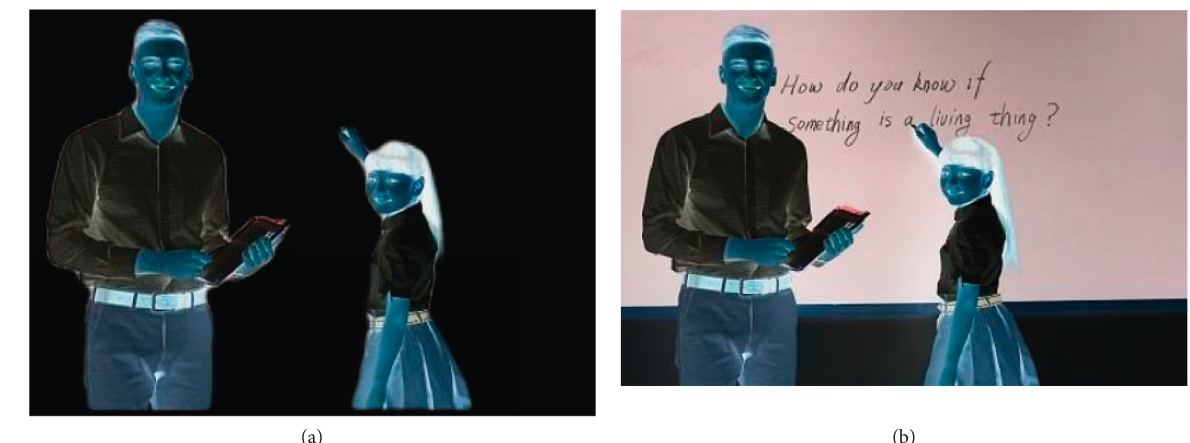
Figure 8: Example of foreign language teaching simulation. (a) Construction of virtual portraits in foreign language teaching. (b) Construction of foreign language teaching